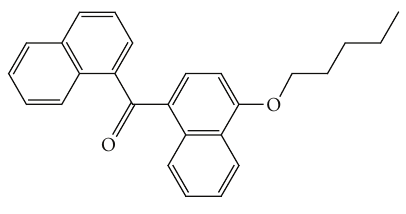
Figure 1: CB13 structural formula (C 26 H 24 O 2